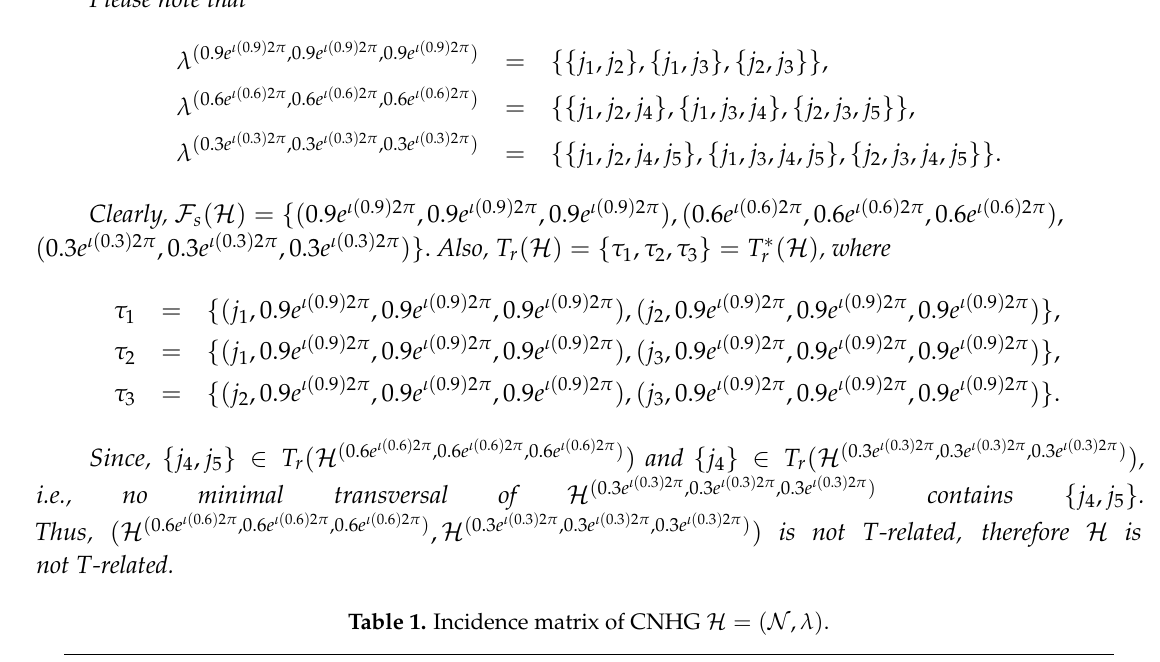
Table 1. Incidence matrix of CNHG